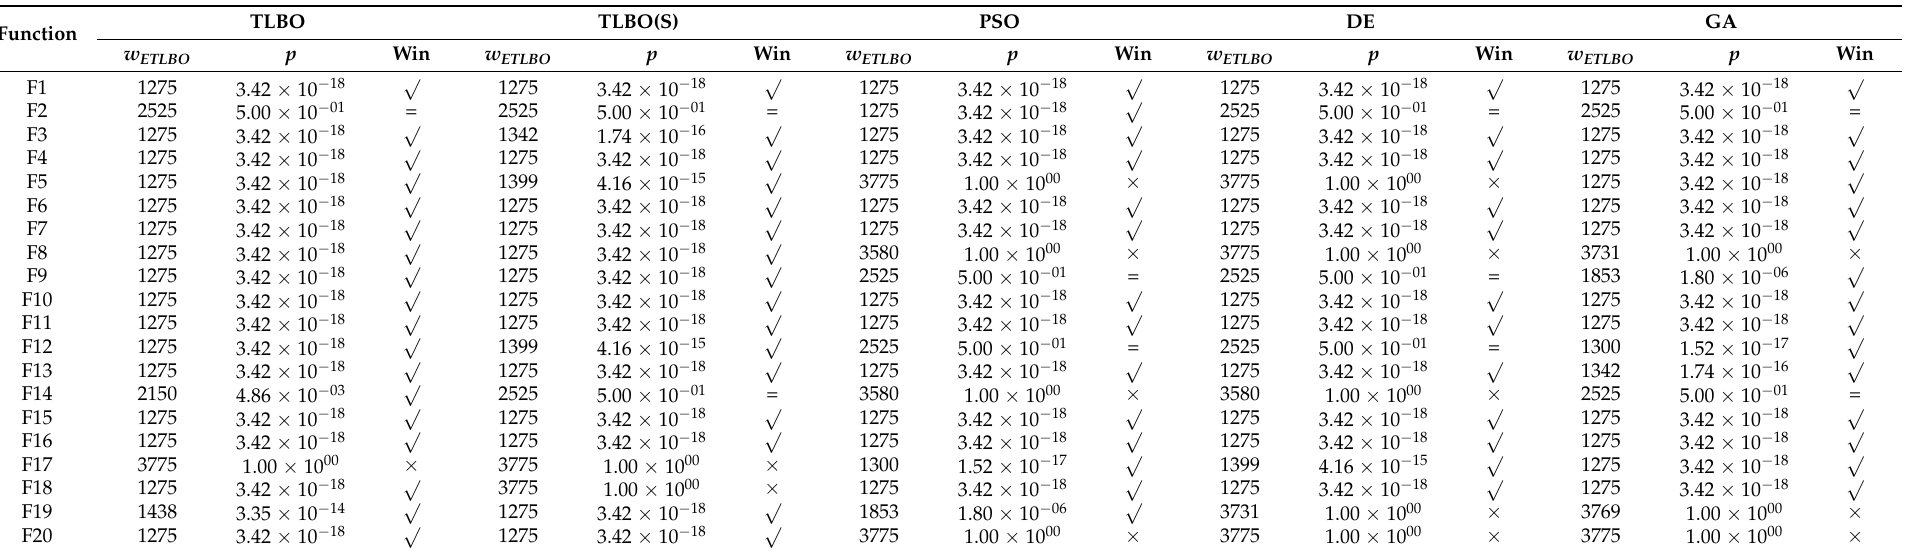
Table 5. Wilcoxon rank-sum test for benchmark function